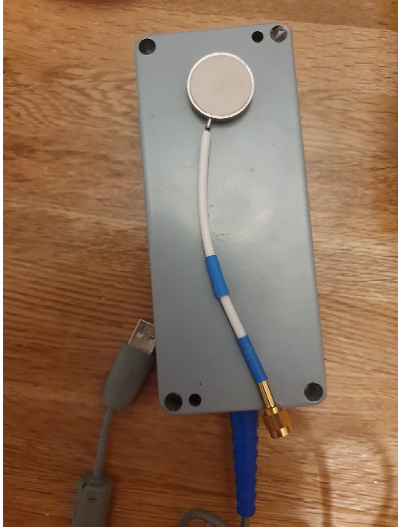
Figure 2. RTMM device with USB connector.